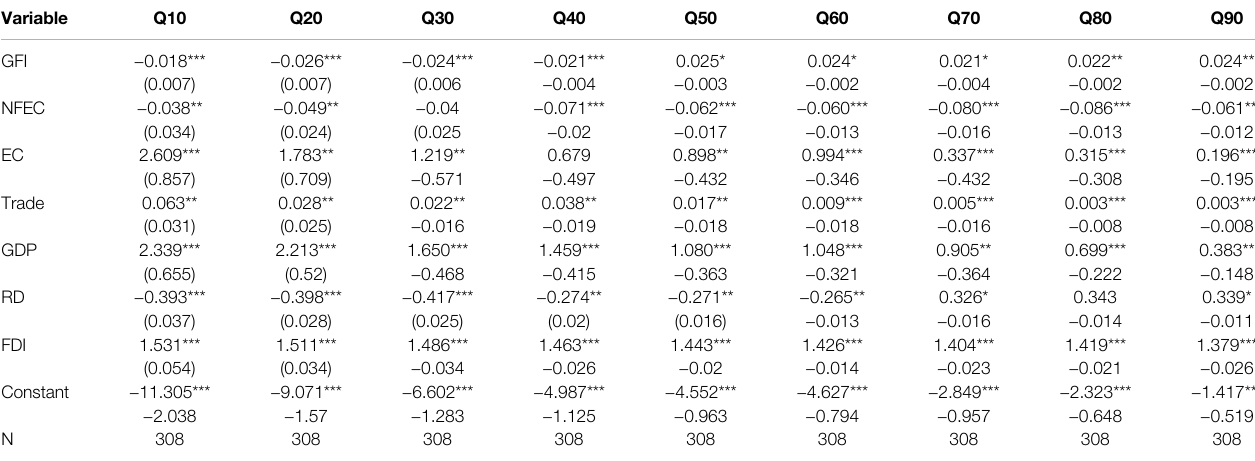
TABLE 5 | Panel quantile regression with fi xed effects results. Variable